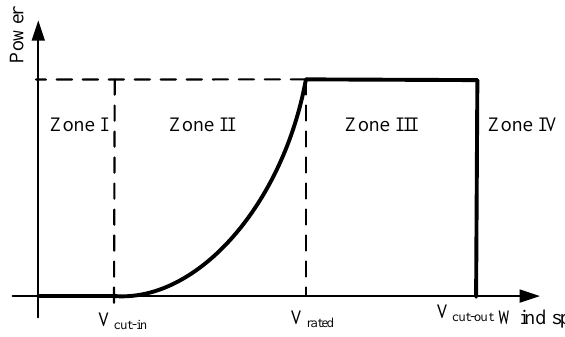
Figure 7. Operational zones of a wind turbine depending on the wind speed [39].